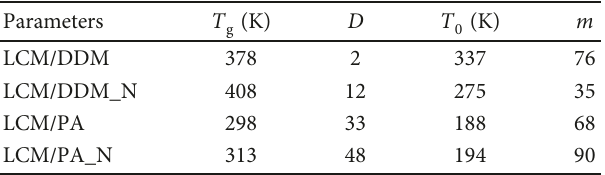
Figure 5: Temperature dependency of the relaxation times for all the observed processes, with the VFT formula fi tted to the α -processes and the Arrhenius formula fi tted to the β -processes: (a) monomer cured with DDM and nano fi ller additive (inset: pure LCM/DDM mixture); (b) monomer cured with PA and nano fi ller additive (inset: pure LCM/PA mixture). ″ = 10 2 s and fragility τ Table 3: Glass transition temperature T g M index m for each of the investigated mixtures. Fragility index values obtained from VFT equation (11) and formula